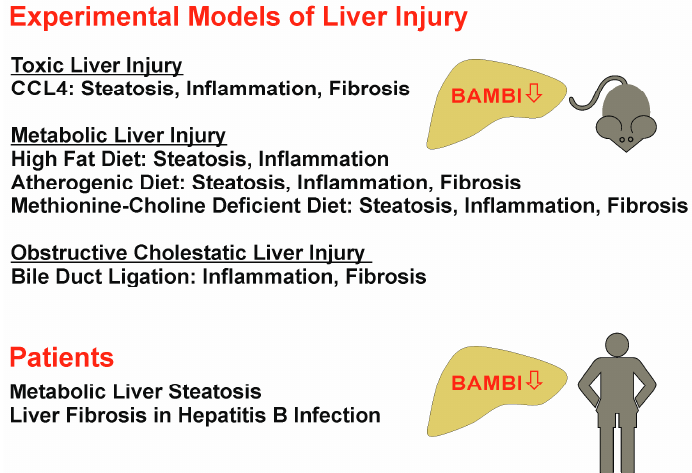
Figure 5. Toxic, metabolic, and obstructive cholestatic liver injury are associated with low hepatic BAMBI in murine models (carbon tetrachloride: CCL4). In patients, low BAMBI expression was described in the steatotic liver and in the fibrotic liver of patients infected with hepatitis B virus.